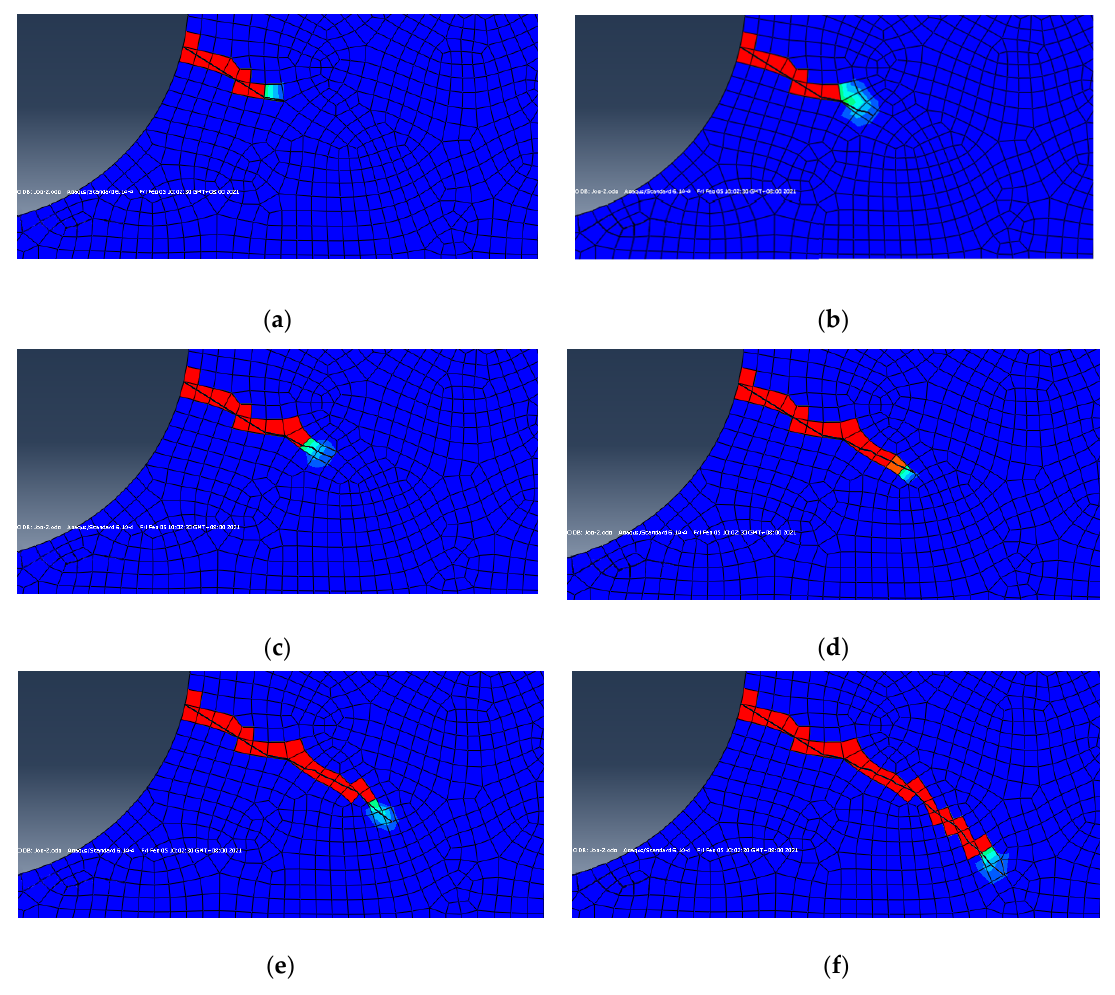
Figure 8. The crack growth process diagram: ( a ) 0 cycles; ( b ) 50 cycles; ( c ) 100 cycles; ( d ) 150 cycles; ( e ) 200 cycles; and ( f ) 250 cycles.